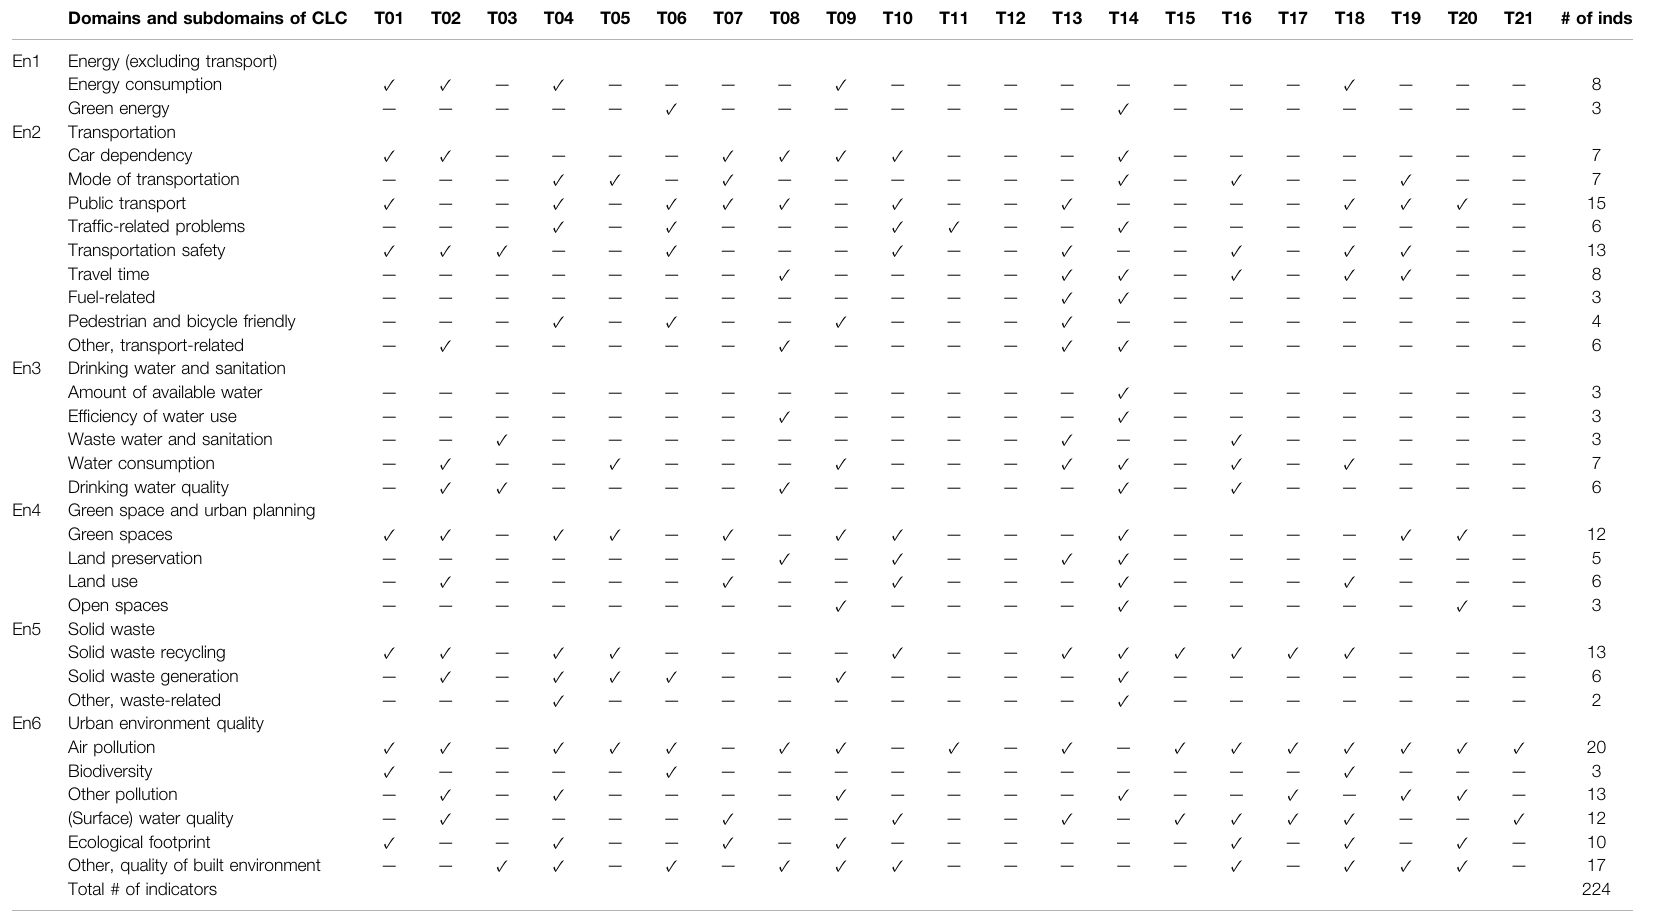
TABLE 3 | Coverage analysis of the 21 tools relative to QOL CLC – environment-related criteria. Domains and subdomains of CLC En1 Energy (excluding transport) Energy consumption Transportation Car